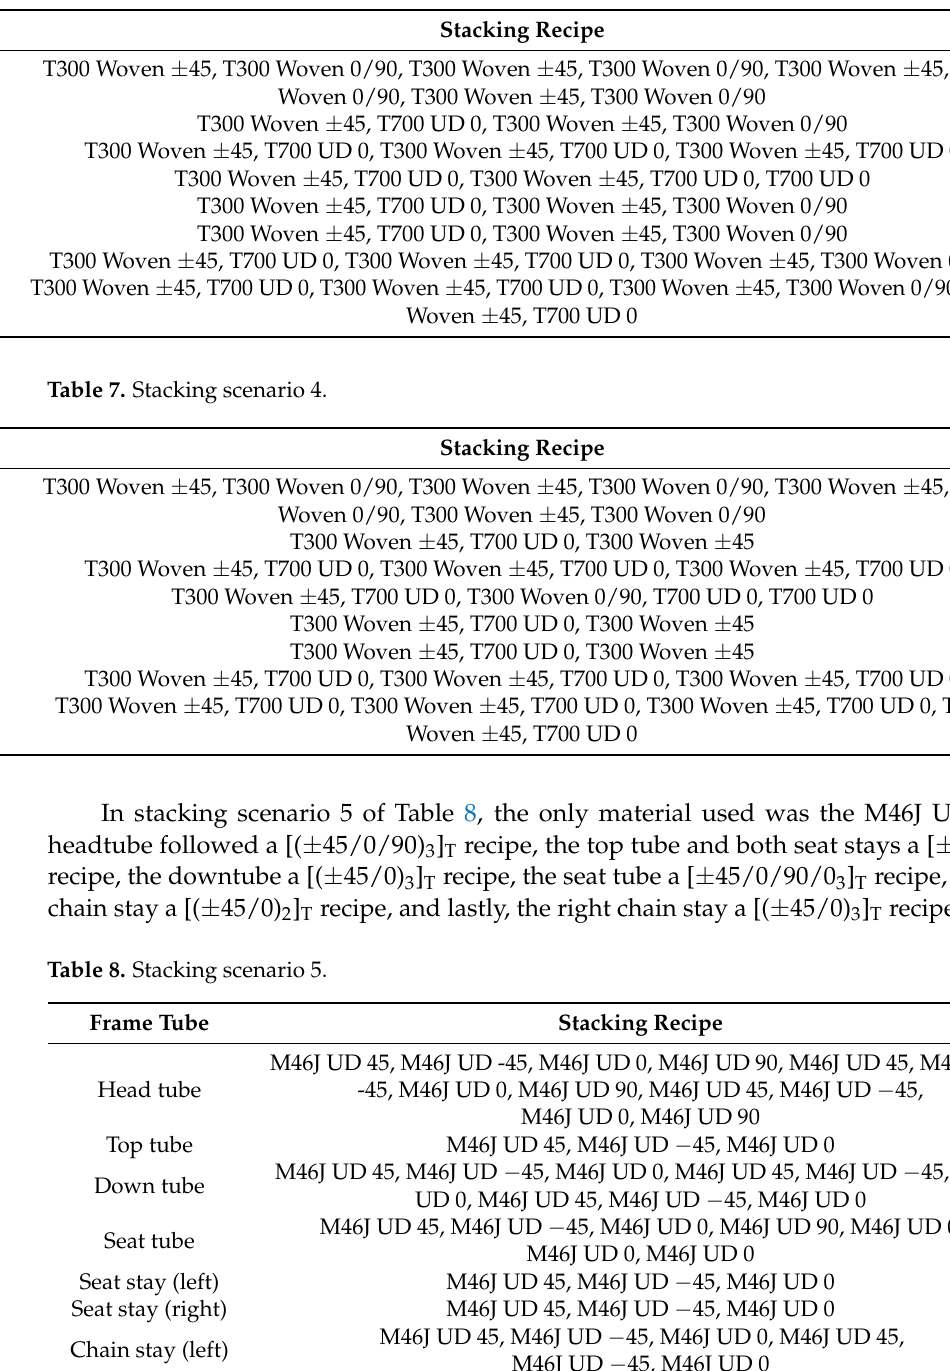
Table 6. Stacking scenario 3.